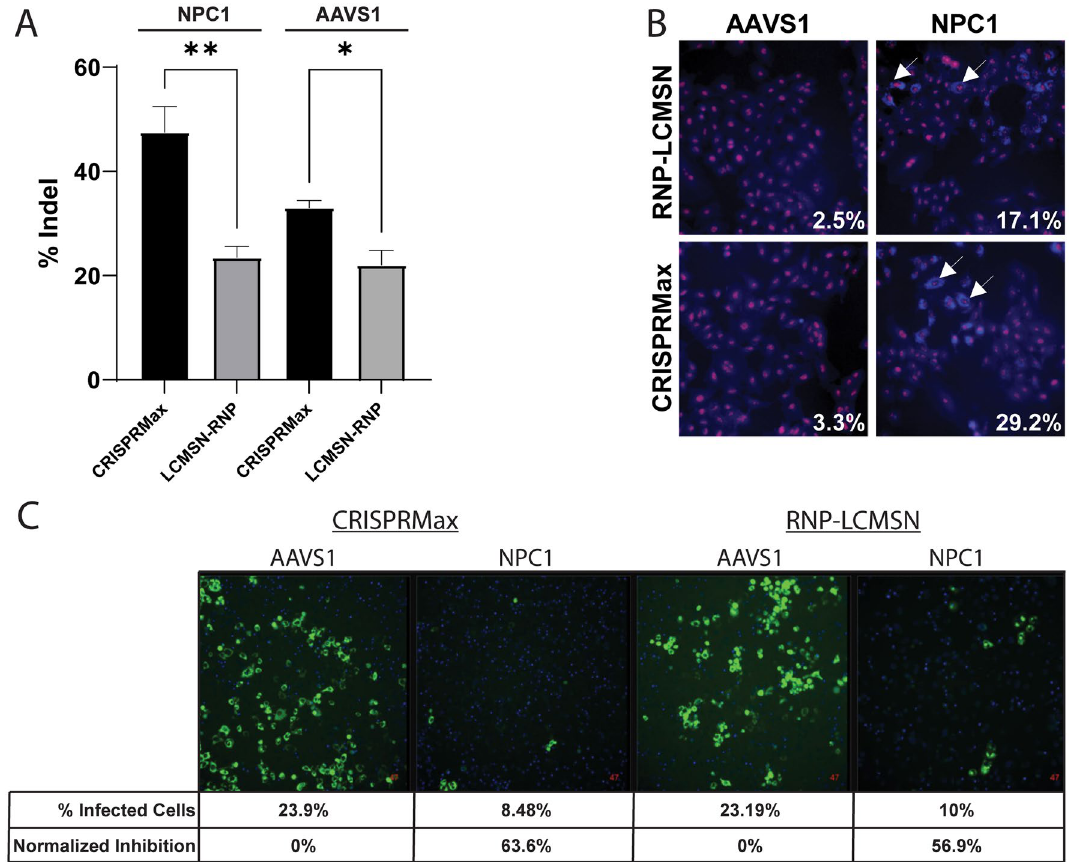
Figure 5. RNP-LCMSNs prevent viral infection in vitro. ( A ) Percent of Insertion/Deletion (Indel) mutations following treatment with RNPs targeting NPC1 or AAVS1 genes in A549 cells as determined by Synthego ICE analysis. ** p < 0.005; * p < 0.05. ( B ) Filipin staining of edited cells showing accumulation of free cholesterol following NPC1 knock-out (KO). Arrows indicate filipin staining examples and cells were counterstained with propidium iodide (red). ( C ) Percent of cells infected in NPC1 KO and AAVS1 KO A549 cell populations following inoculation with VSV-EBOV-GFP (MOI =